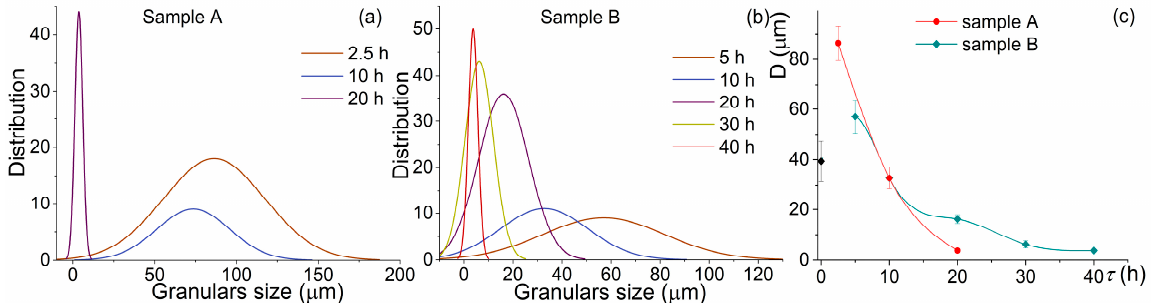
Figure 3. Evolution of ( a , b ) the distribution of the granular size and ( c ) a mean size value during the high-energy ball milling of ( a ) sample A and ( b ) the pre-milled sample B.